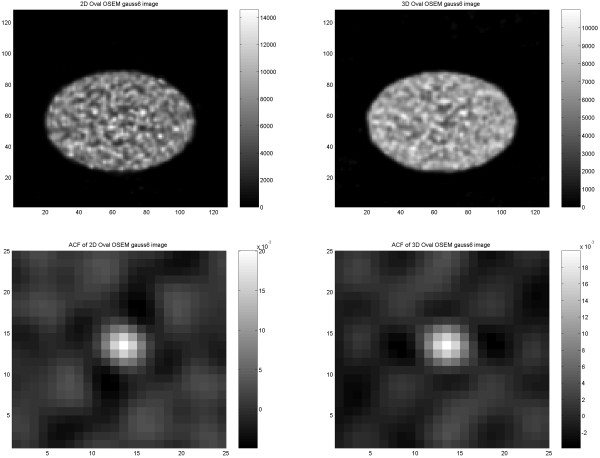
Results of the elliptical torso phantom study. 2D image (upper left) and 3D image (upper right) reconstructed using OSEM with applied 6 mm (FWHM) Gaussian filter. Corresponding ACF images of 2D (lower left) and 3D image (lower right).